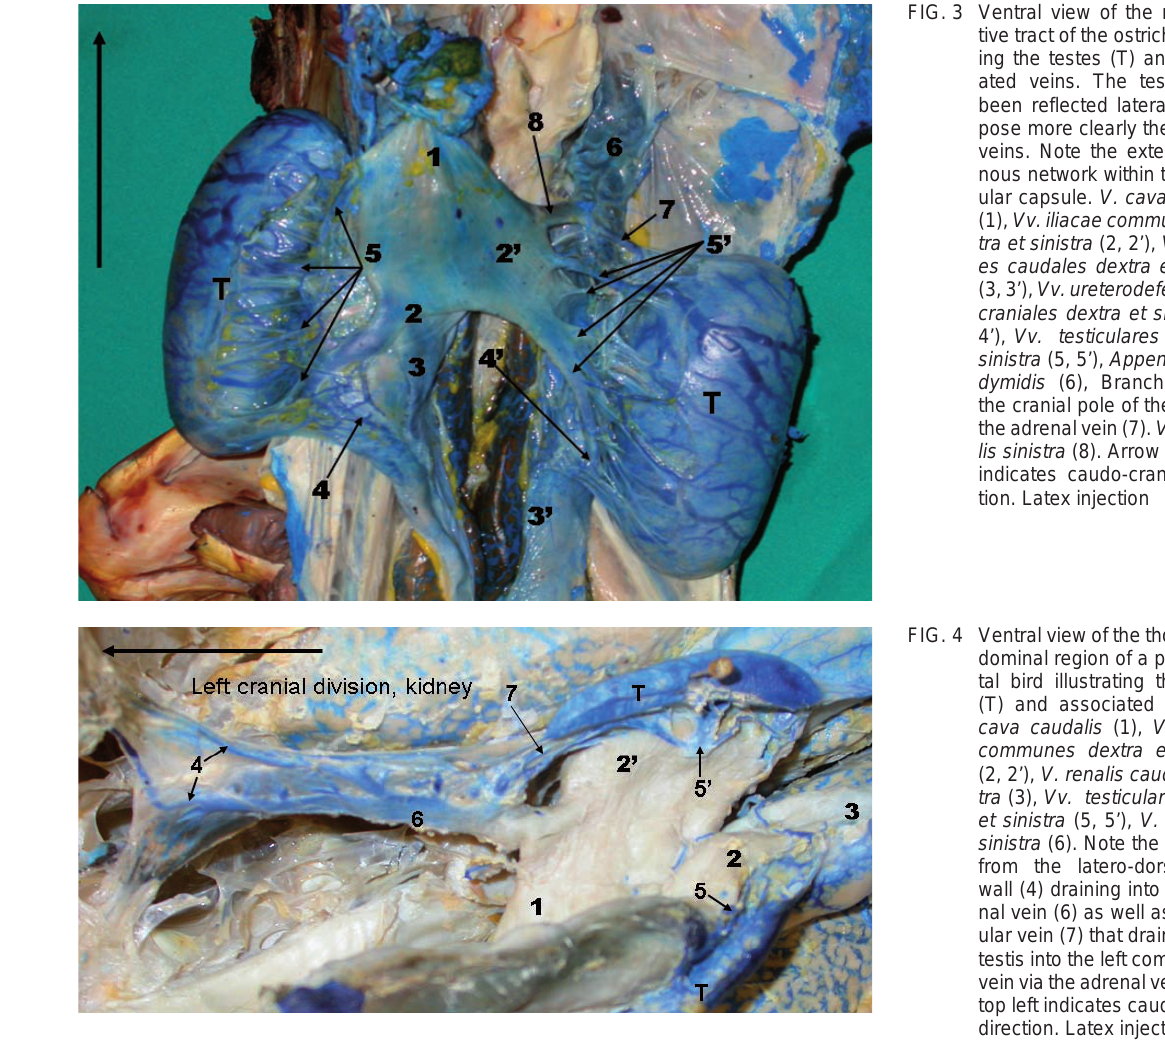
FIG. 3 Ventral view of the reproduc- tive tract of the ostrich illustrat- ing the testes (T) and associ- ated veins. The testes have been reflected laterally to ex- pose more clearly the relevant veins. Note the extensive ve- nous network within the testic- ular capsule. V. cava caudalis (1), Vv. iliacae communes dex- tra et sinistra (2, 2’), Vv. renal- es caudales dextra et sinistra (3, 3’), Vv. ureterodeferentiales craniales dextra et sinistra (4, 4’), Vv. testiculares dextra et sinistra (5, 5’), Appendix epidi- dymidis (6), Branch draining the cranial pole of the testis to the adrenal vein (7). V. adrena- lis sinistra (8). Arrow at top left indicates caudo-cranial direc- tion. Latex injection